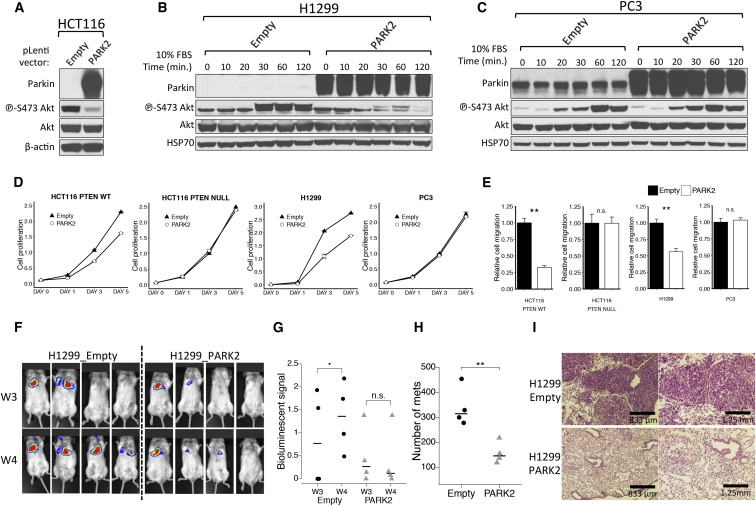
PARK2 Overexpression Suppresses Akt Activation and Mitigates Cell Proliferation and Migration in PTEN Wild-Type, but Not PTEN Mutant, Cells(A–C) Immunoblotting analysis of (A) HCT116 cells transfected with vector only or vector encoding WT PARK2, (B) PTEN WT H1299 cells, and (C) PTEN mutant PC3 cells expressing vector only or vector encoding WT PARK2 following 10% fetal bovine serum (FBS) stimulation. Cells were serum-starved for 24 hr prior to FBS stimulation.(D and E) Shown are the (D) cell proliferation (HCT116 PTEN+/+, p = 0.002; HCT116 PTEN−/−, p = 0.99; H1299, p = 3.4 × 10−5; and PC3, p = 0.66, two-way ANOVA) and (E) cell migration assays of PTEN WT (HCT116 PTEN+/+ and H1299) and PTEN-deficient (HCT116 PTEN−/− and PC3) cells expressing vector only or vector encoding WT PARK2 (HCT116 PTEN+/+, p = 8.1 × 10−4; HCT116 PTEN−/−, p = 0.99; H1299, p = 4.7 × 10−3; and PC3, p = 0.68).(F) BLI images of NOD/SCID mice retro-orbitally injected with luciferase-labeled H1299 cells expressing EV or human PARK2. Images were taken at 3 and 4 weeks post-injection (W3 and W4) to assess for luciferase-expressing lung metastases.(G) Quantification of BLI intensities on weeks 3 and 4 post-injection (EV, p = 0.02; and human PARK2, p = 0.54). The lungs were then dissected from the mice for H&E staining.(H) Scatterplot indicating that overexpression of PARK2 significantly mitigated the formation of lung metastases in NOD/SCID mice (p = 0.006).(I) Representative H&E staining of lung sections 4 weeks post-injection to highlight significantly more and larger size metastatic tumor lesions in the mice injected with vector only or with vector encoding WT PARK2 H1299 cells. Data are represented as mean ± SEM (n.s., not significant; ∗p < 0.05 and ∗∗p < 0.01, two-tailed t test).See also Figure S2.